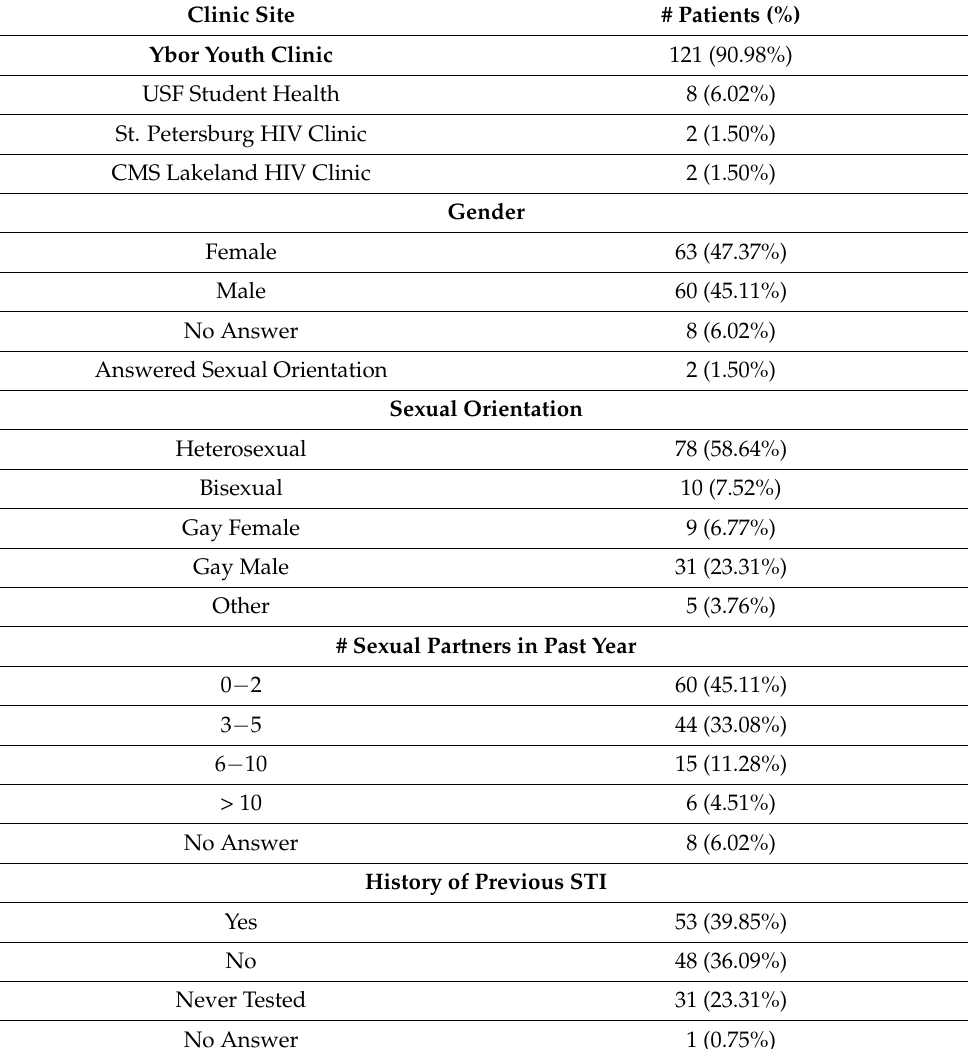
Table 1. Characteristics of Patients Who Completed